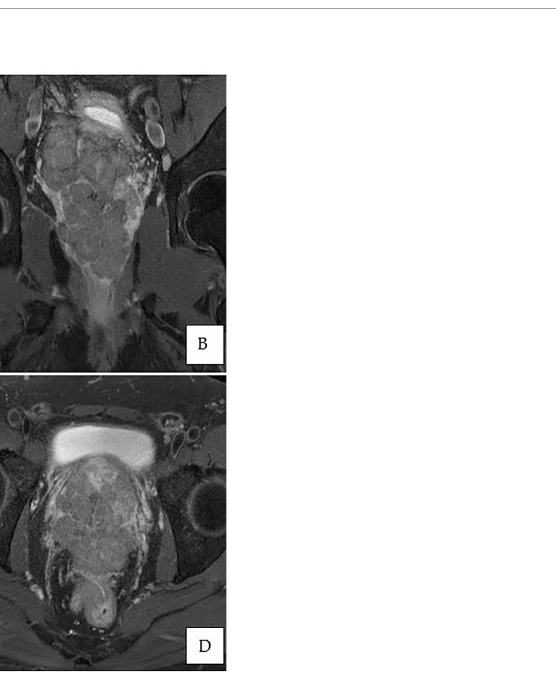
FIGURE 3 MRI of the prostate. (A) Axial T2-weighted image showing an enlarged prostate gland with a multilobulated appearance involving all zones, predominantly the peripheral zone, measuring 7.3 × 7.4 × 9.1 cm (volume: 255 cm 3 ). (B) Post-contrast coronal T1-weighted fat saturation demonstrates peripheral enhancement extending to the capsule of the prostate. (C, D) Post-contrast axial T1-weighted fat saturation exhibiting involvement of the bilateral seminal vesicles and invasion of the